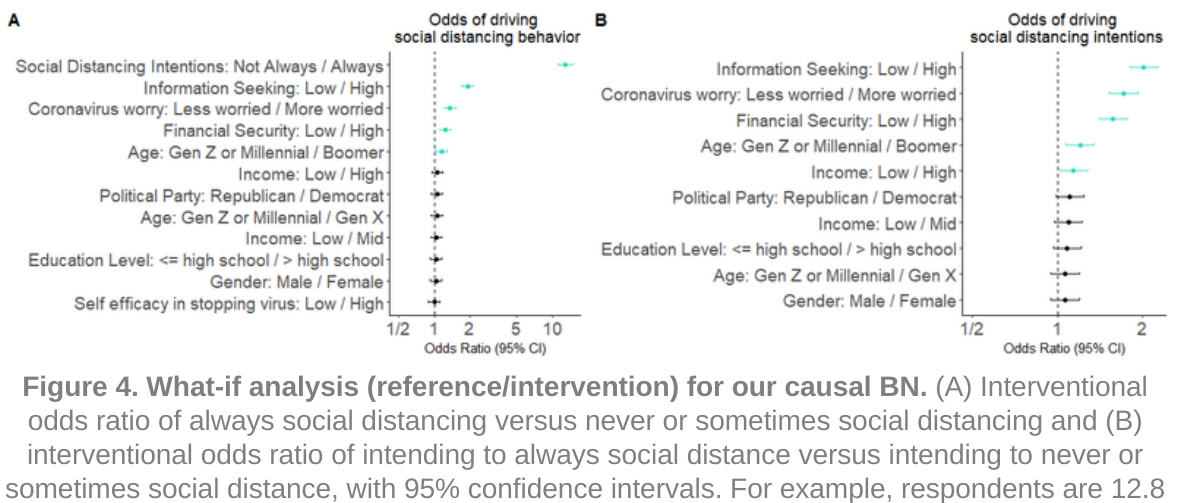
Figure 4. What-if analysis (reference/intervention) for our causal BN. (A) Interventional odds ratio of always social distancing versus never or sometimes social distancing and (B) interventional odds ratio of intending to always social distance versus intending to never or sometimes social distance, with 95% confidence intervals. For example, respondents are 12.8 times more likely to social distance if one is able to persuade them to always intend to do